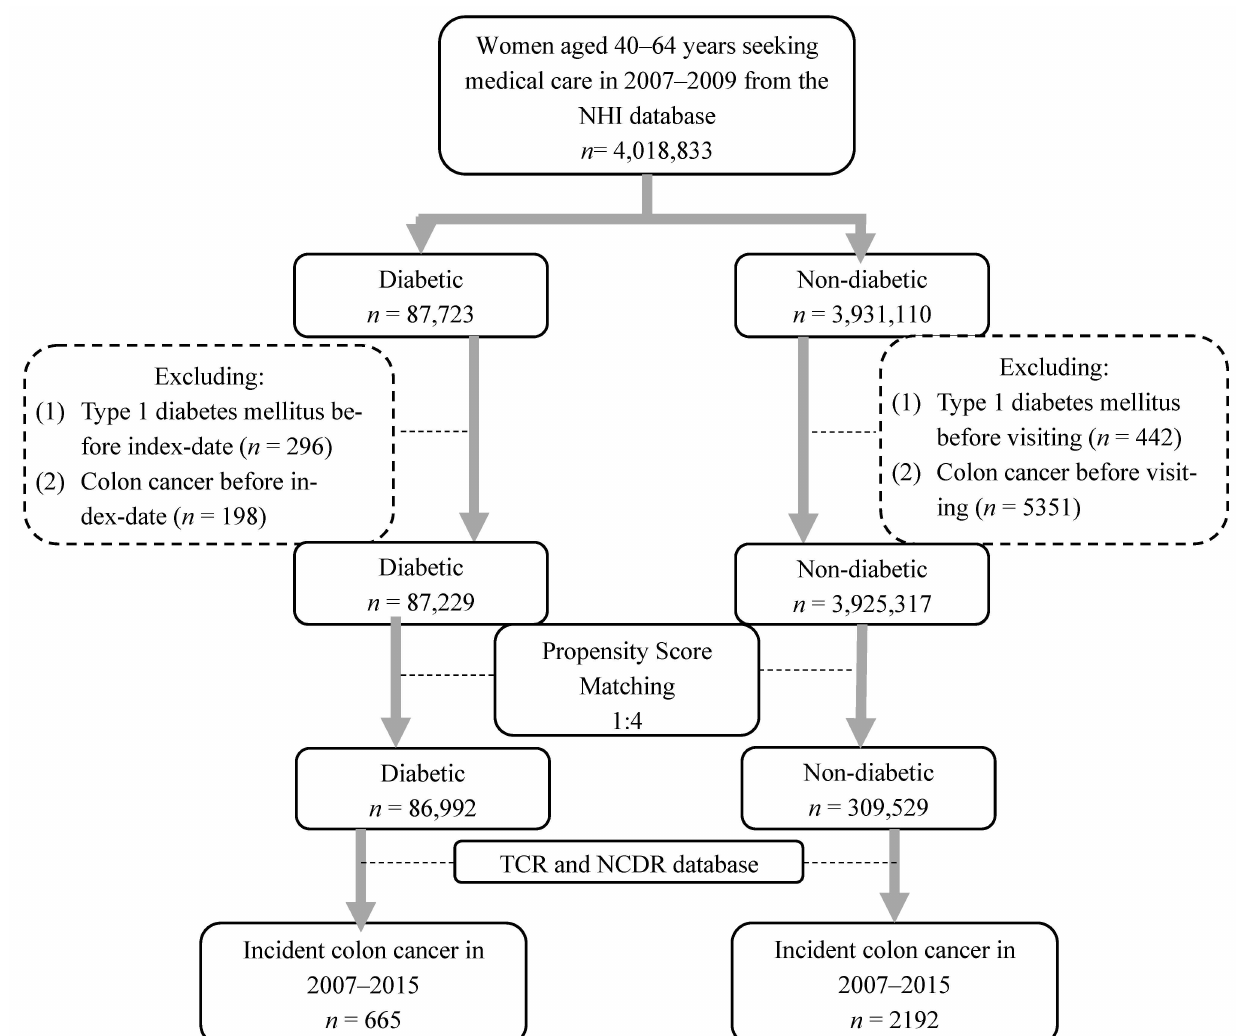
Figure 1. Flow chart for the selection of study